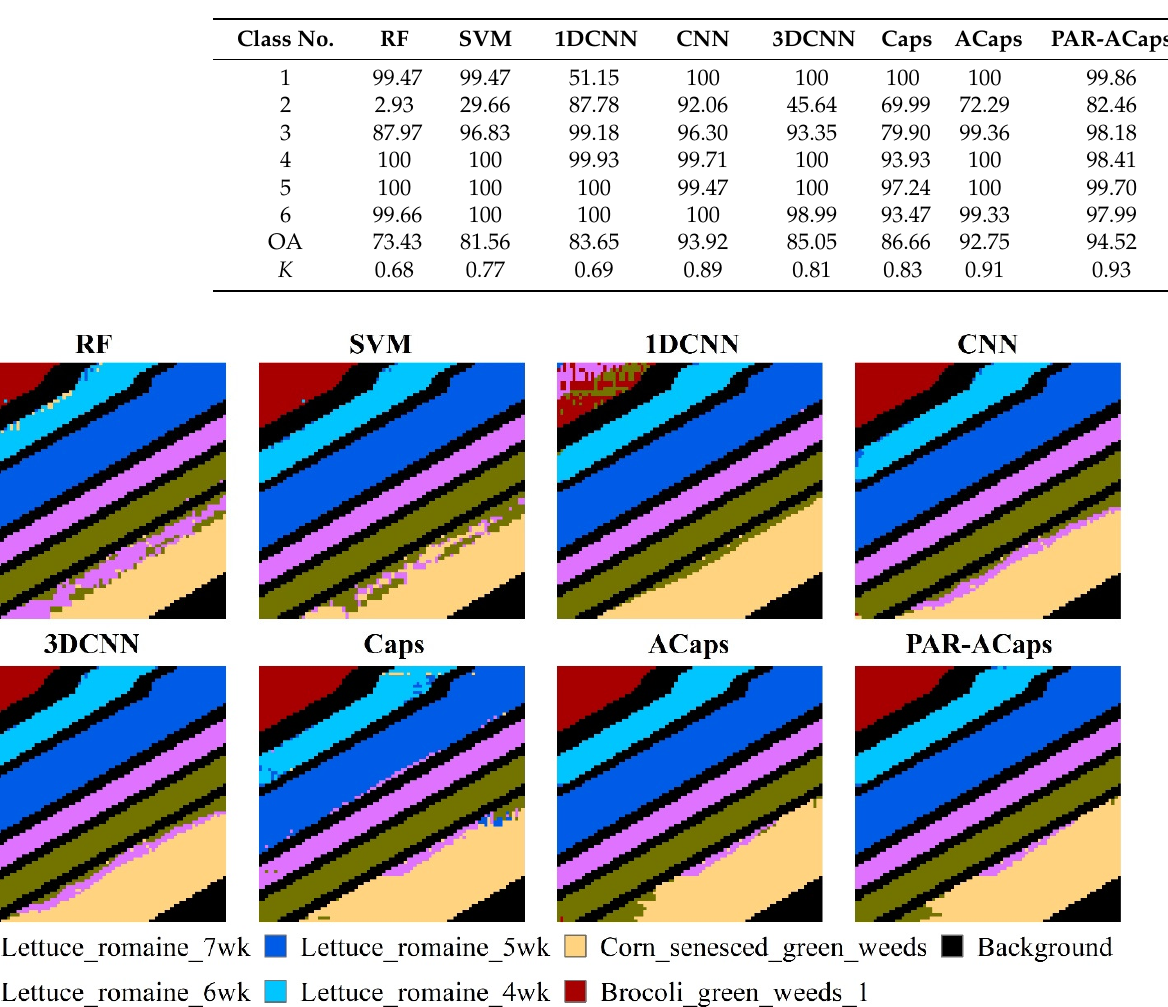
Table 4. The overall accuracy (%), per-class accuracy (%), and the Kappa coefficients ( K ) between the ACaps and other classification methods in terms of classification accuracy with SA dataset; class names are in Table 1.